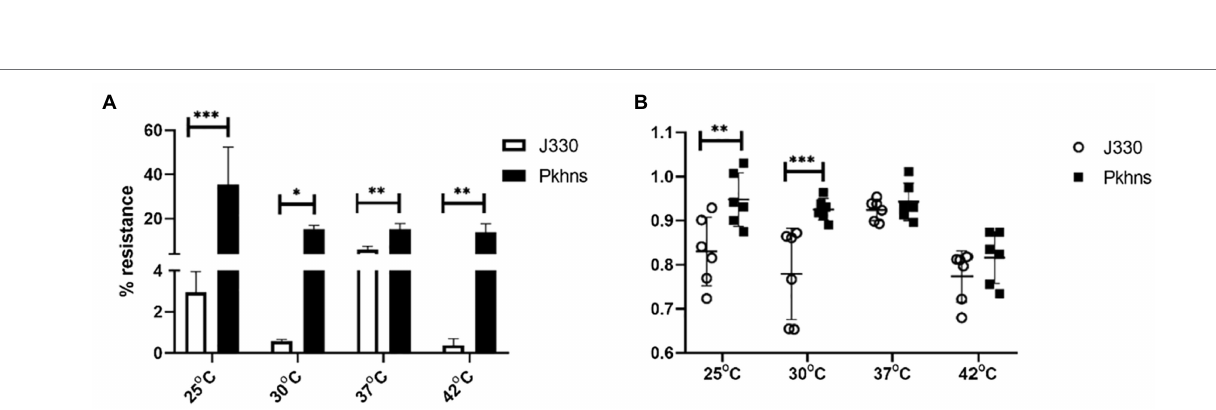
FIGURE 7 | At various temperature, the impact of plasmid-encoded H-NS-like protein on IncX3 plasmid stability (A) and fitness cost (B) in E. coli . (A) Plasmid stability is estimated by the percent of plasmid-containing E. coli at 24 h (% resistance). (B) Fitness index is calculated by formula described in Section “Materials and Methods.” The higher fitness index represents better fitness of plasmid-containing strains. Significant differences are indicated with * ( p < 0.05), ** ( p < 0.01), and *** ( p <